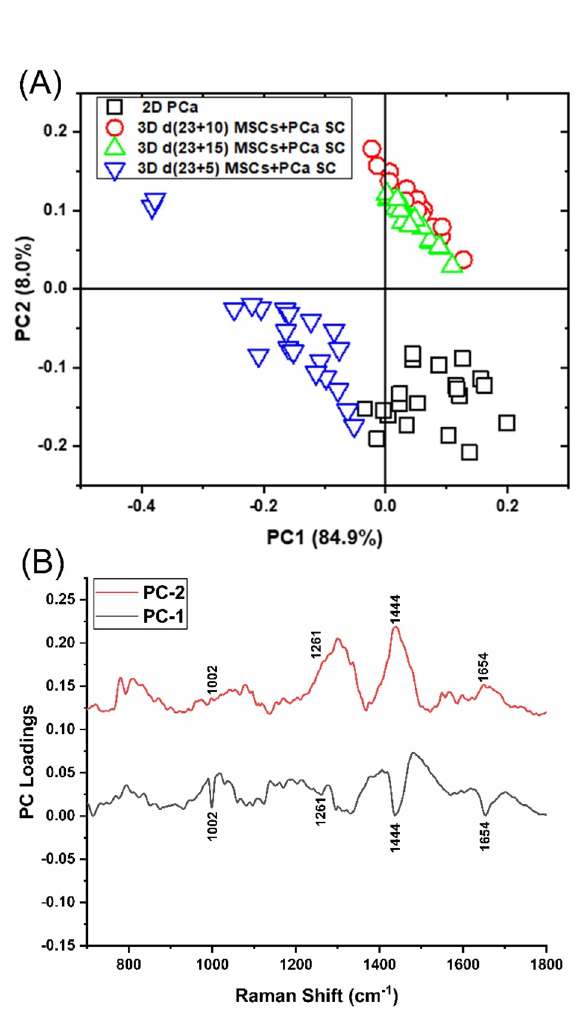
Figure 2. PCA analysis of Raman spectra. ( A ) PCA score plot spanned by PC1 and PC2, illustrating the intrinsic clustering of 2D PCa and 3D MSCs + PCa SCs. ( B ) The first two PCs accounting for 92.9% of the total variation in the Raman spectral dataset, revealing the significant Raman spectral features for the classification of cancer